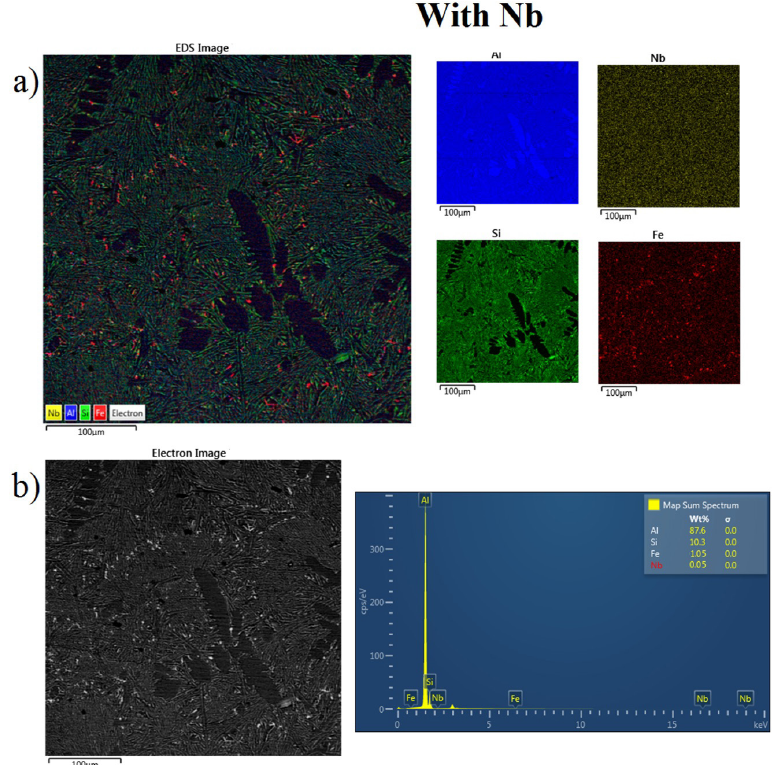
Figure 10. MEV: a) SEM-EDS image shows the microstructure of the alloys containing Al12Si1Fe with 0.05 wt.% of Nb addition. b) Electron image shows Al, Si, Fe, and Nb map sum spectrum.